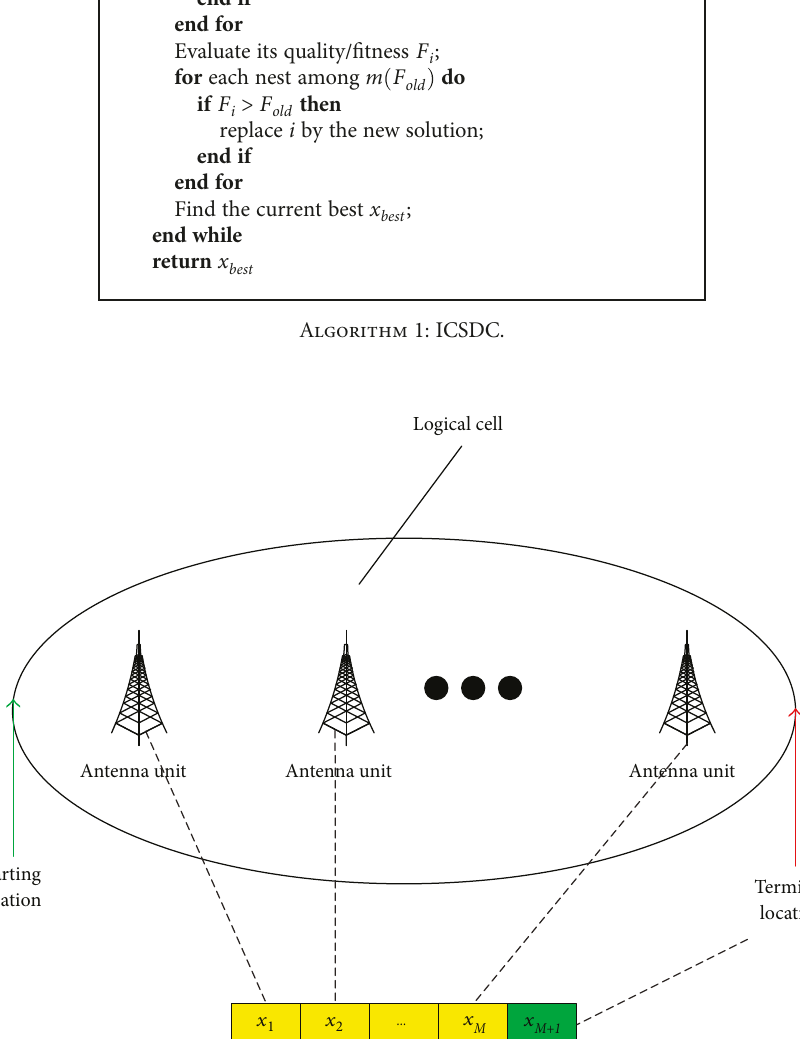
Figure 4: The encoding of